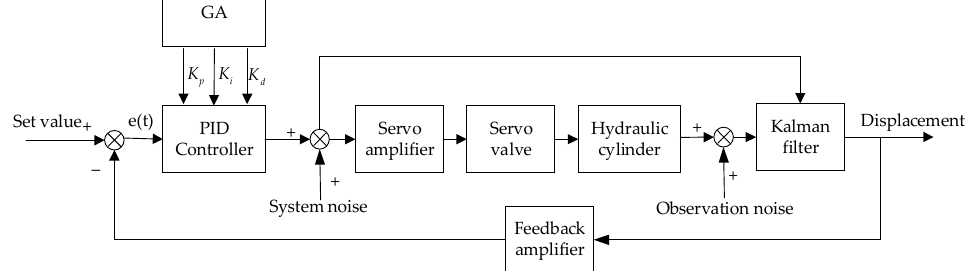
Figure 7. PID position control of hydraulic servo system based on Kalman genetic optimization.